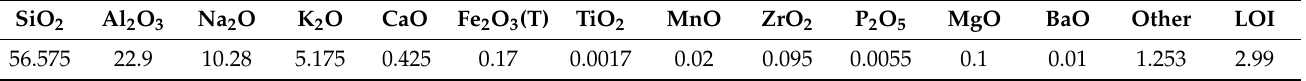
Figure 11. XRD pattern of Zr-REE-bearing concentrate. Table 6. Chemical composition of flotation tailings (nepheline syenite products) (in